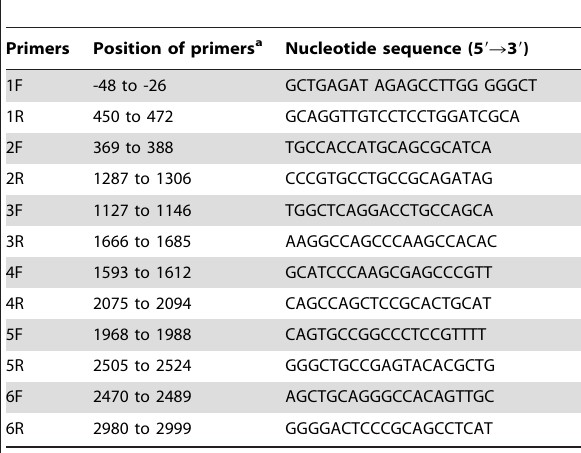
Table 5. Primers for the RT-PCR and Sequencing of Chicken PIG-O cDNA.